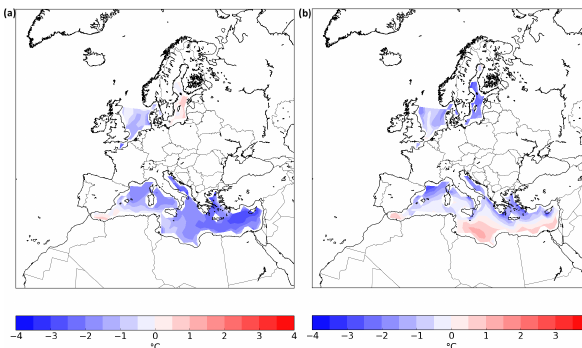
Figure 7. Spatial distribution of coupled simulation–observation SST differences in (a) winter and (b)